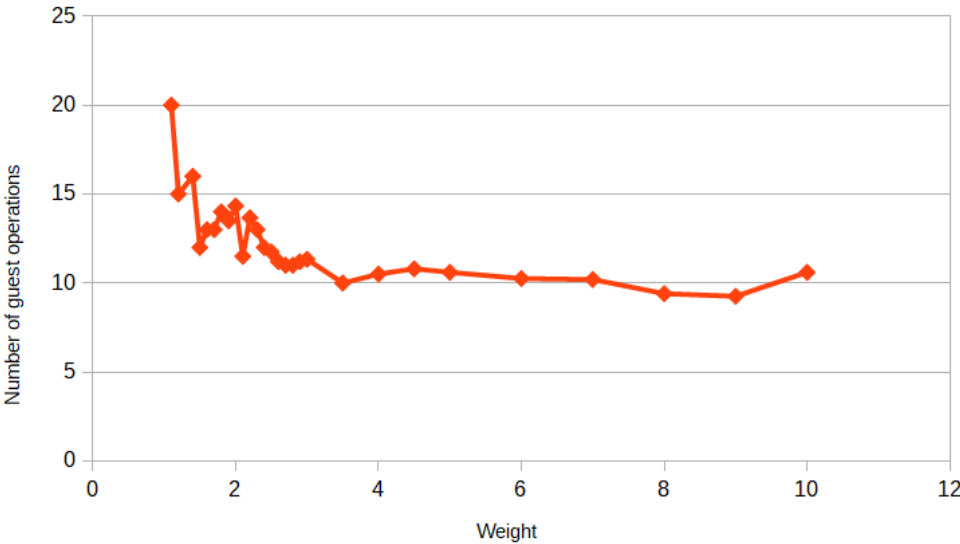
Figure 4. More detailed dependency diagram of the number of guest surgeries on the weight w 0 , 1 ≤ w o ≤